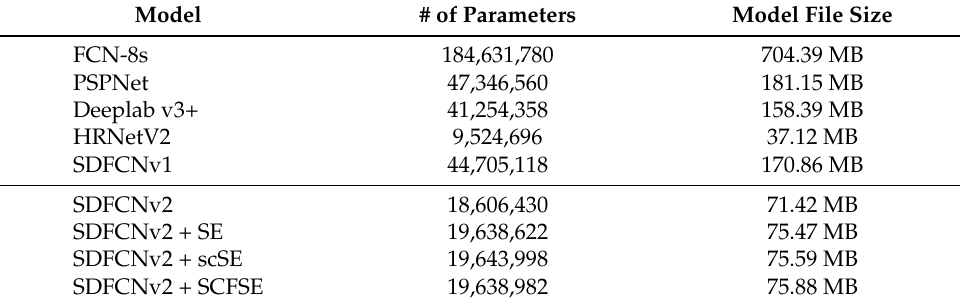
Table 1. The number of parameters and compressed model file size of each FCN model Model # of Parameters Model File